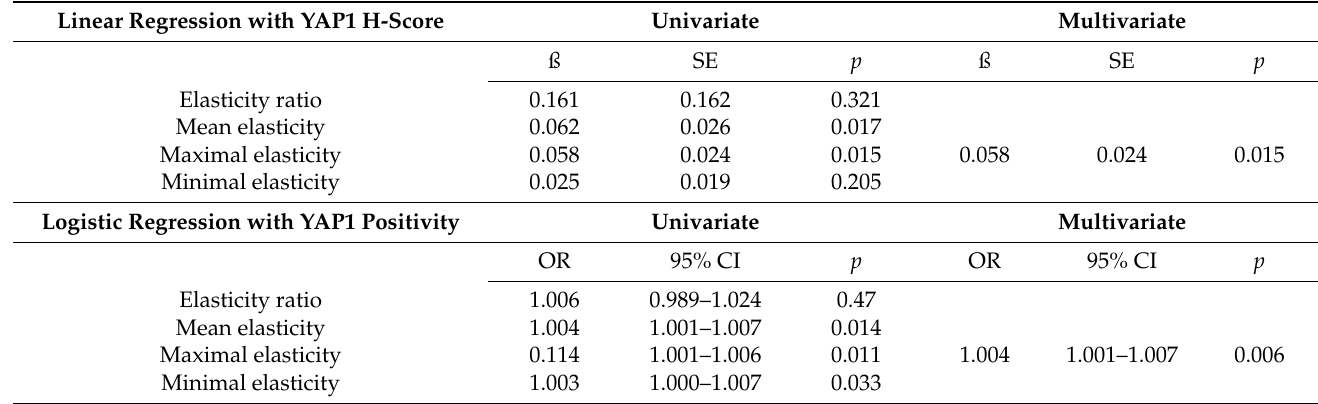
Table A2. Correlation between YAP1 expression and tumor stiffness and elasticity ratio in all patients. Linear Regression with YAP1 H-Score Univariate Multivariate ß Elasticity ratio